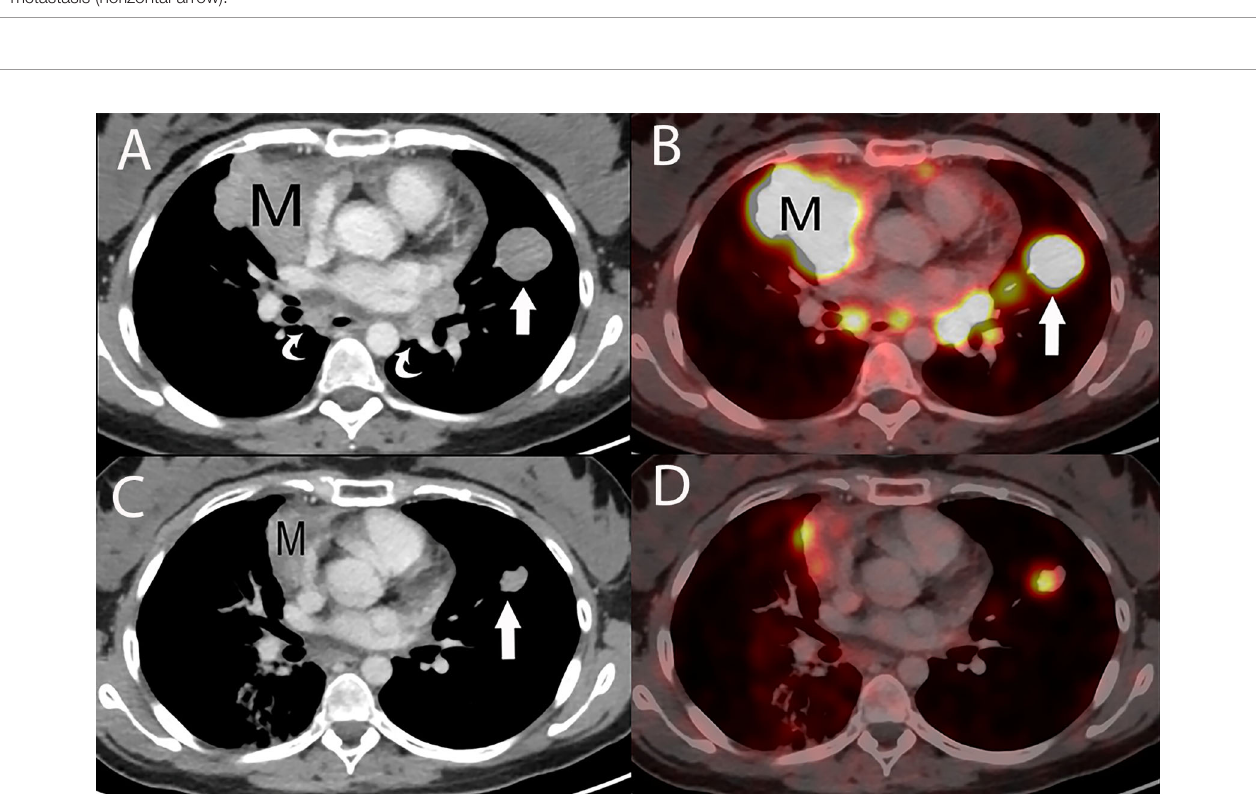
FIGURE 14 | 29 year old woman with metastatic thymic carcinoma treated with peptide receptor radiotherapy (PRRT) with 177 Lutetium. (A) Baseline contrast enhanced chest CT prior to PRRT treatment shows the primary prevascular mass (M), lung metastasis (straight arrow) and metastatic mediastinal lymphadenopathy (curved arrows). (B) Axial fused PET/CT scan at the same level as A, using a somatostatin analogue, Ga 68 -DOTATATE, reveals DOTATATE uptake in the primary mass (M), lung metastasis (straight arrow) and mediastinal lymphadenopathy. (C) Contrast enhanced chest CT, following two peptide receptor radiotherapy (PRRT) with 177 Lutetium sessions show an impressive partial response with a decrease in size of the primary mass (M) and of the lung metastasis (straight arrow), with resolution of the mediastinal lymphadenopathy. (D) Axial fused Ga 68 -DOTATATE PET/CT scan at the same level as C, shows a corresponding marked decrease in DOTATATE uptake consistent with an impressive metabolic partial